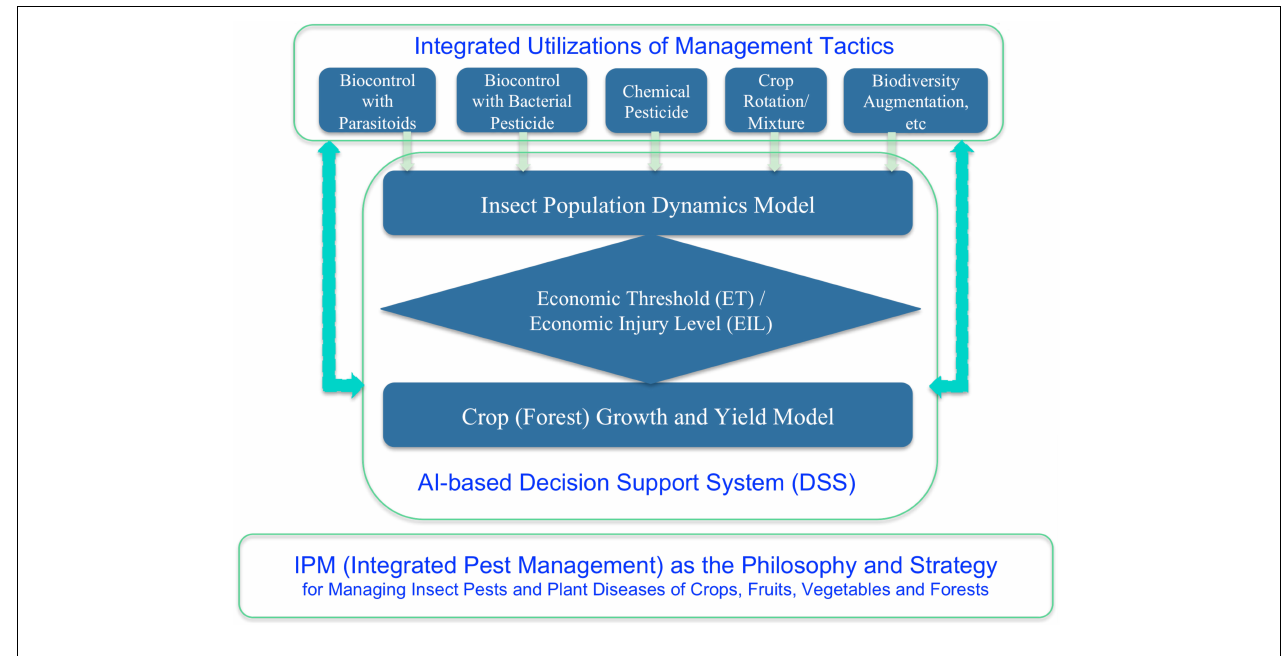
FIGURE 3 | Strategy, tactics, and decision-making in the integrated pest management (IPM).